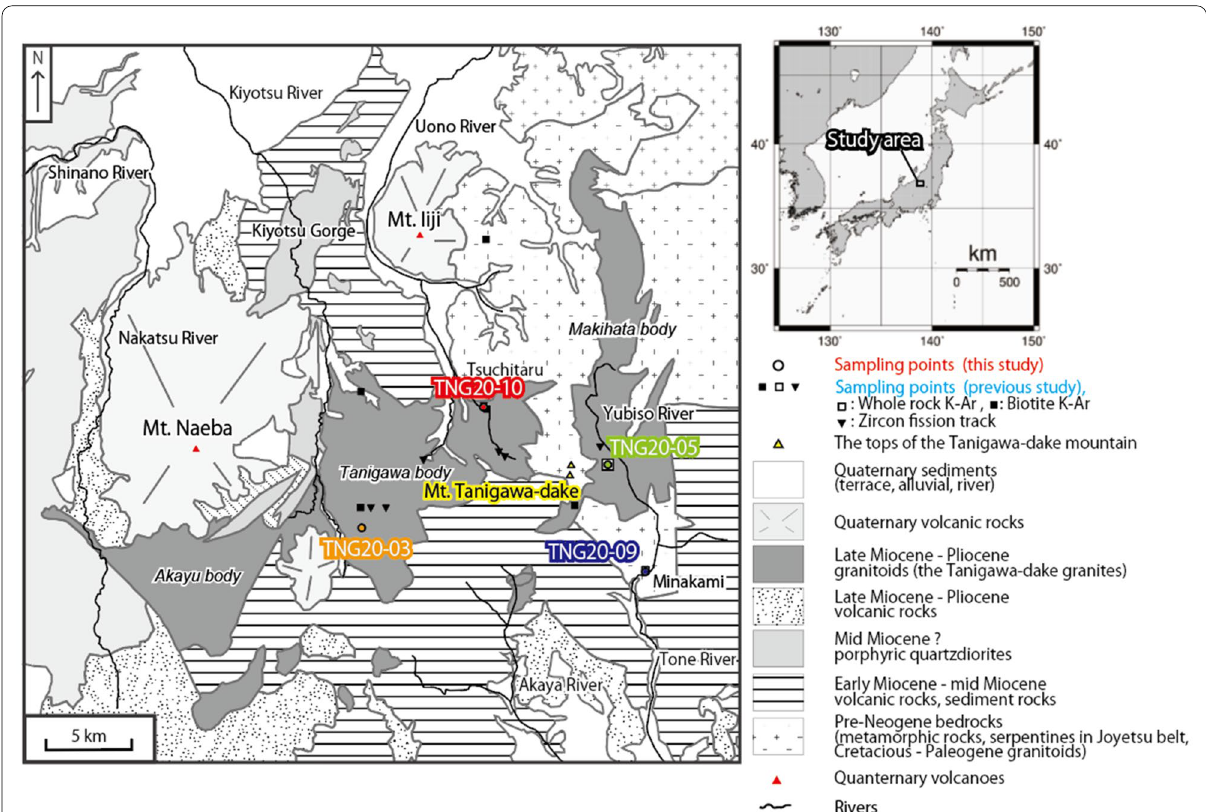
Fig. 1 Index map of the study area. The geologic map was modified from Sato (2016) and Geological Survey of Japan web page (https:// gbank. gsj. jp/ geona vi/ geona vi. php# 11,36. 83525 ,138. 87626). Circle points denote sampling localities. Colored circles denote sampling localities in this study. Sampling sites of the previous studies are shown by the following symbols. Filled square: K–Ar ages of biotite (Kawano et al. 1992; Sato 2016; Shibata et al. 1984), open squares: K–Ar ages of whole rock (Kubo et al. 2013), filled inverted triangles: fission-track ages of zircon (Ohira et al. 1998; Ohira and Honda 1999). Note that the sites of TNG20-10 indicated by a red circle overlap the localities of zircon fission-track and biotite K–Ar ages of the previous researches (Kawano et al. 1992; Ohira et al. 1998; Ohira and Honda 1999; Sato 2016). Similarly, the site of TNG20-09 shown by a navy circle overlap the locality of K–Ar age of the whole rock (Kubo et al.